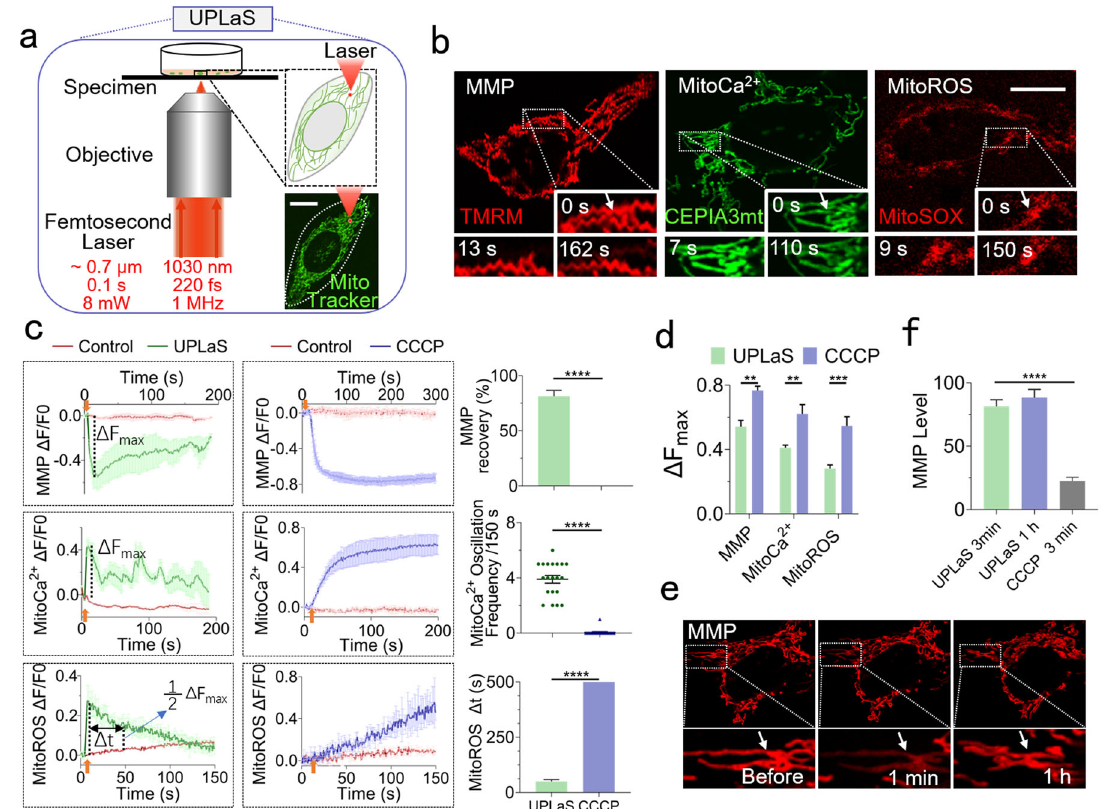
Fig. 1 UPLaS excites mitoCa 2 + oscillations in the target mitochondria with little perturbation to MMP or mitoROS. a The setup of UPLaS based on a microscopic system to focus a femtosecond laser onto a diffraction-limit spot on a target single-mitochondrial tubular structure. The laser is controlled by a shutter. b The individual mitochondrion stimulated by UPLaS. The responses of MMP, mitoCa 2 + , and mitoROS to UPLaS (at t = 5 s) are, respectively, indicated by TMRM, CEPIA3mt, MitoSOX. Inserts: the mitochondrial responses to UPLaS at different time slots. c The MMP ( n = 25), mitoCa 2 + ( n = 20), and mitoROS ( n = 35) level of the mitochondria treated with UPLaS (at t = 5 s) and CCCP (since t = 10 s, 10 μ M), respectively, (left panel). Right panel: the quanti fi ed ratio of recovered MMP level over the original at 200 s, mitoCa 2 + oscillation frequency, and the mitoROS recovery time ( Δ t ) de fi ned by the width at the half maximum of the mitoROS curve, in the mitochondria treated with UPLaS. The Δ t by CCCP was de fi ned as 500 s due to its continuous rise in 500 s. Arrows: the UPLaS or CCCP treatment events. d The maximum fl uorescence amplitude of the MMP, mitoCa 2 + , and mitoROS level of the mitochondria treated with UPLaS and CCCP, respectively. e The MMP level before, one minute, and one hour after UPLaS. f The quanti fi ed MMP levels by UPLaS and CCCP, respectively. Bar: 20 μ m. * p < 0.05, ** p < 0.01, and *** p <